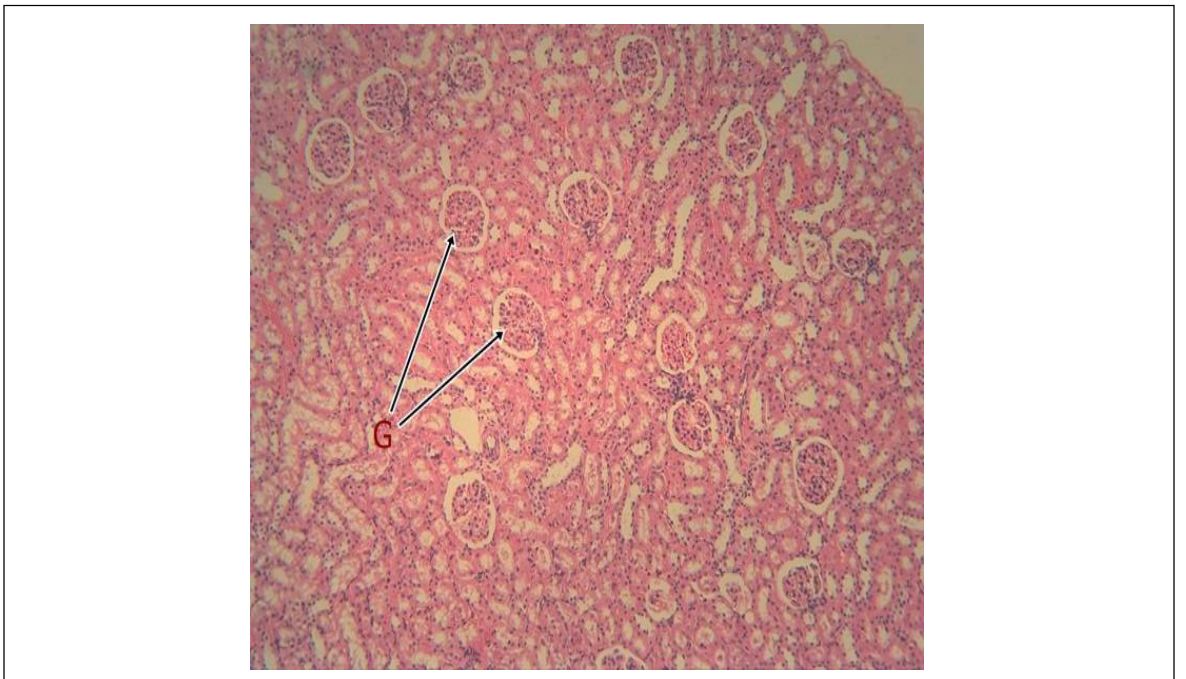
Plate 6: Effect of 8,000 mg/kg MSG on the liver of group F rats Photomicrographs of the kidney section of group A rats administered with N. laevis 200 mg/kg + MSG 8,000 mg/kg showed evenly distributed glomeruli, open glomerular capillaries, normal endothelial epithelium with renal architecture, presence of thin distal and proximal tubules, presence of inflammatory cell (Mg. X400).